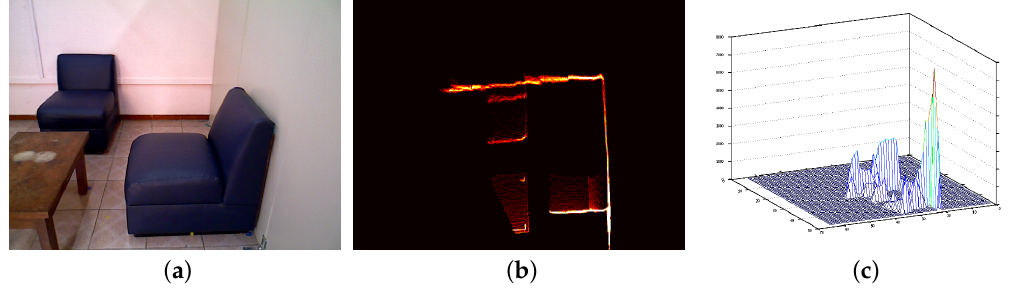
Figure 8. Example of a floor projection and its 2D histogram. In ( a ), the RGB image from the scene, in ( b ), the floor projection, and in ( c ), the 2D histogram.